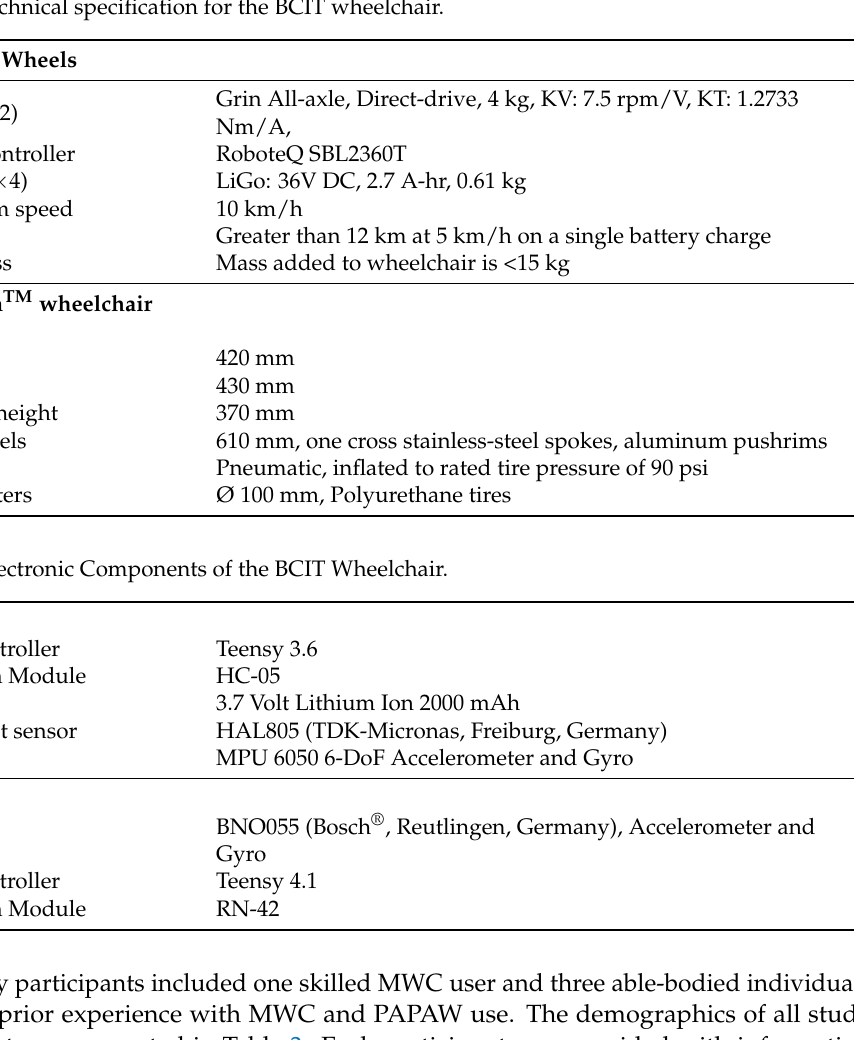
Table 2. Electronic Components of the BCIT Wheelchair.